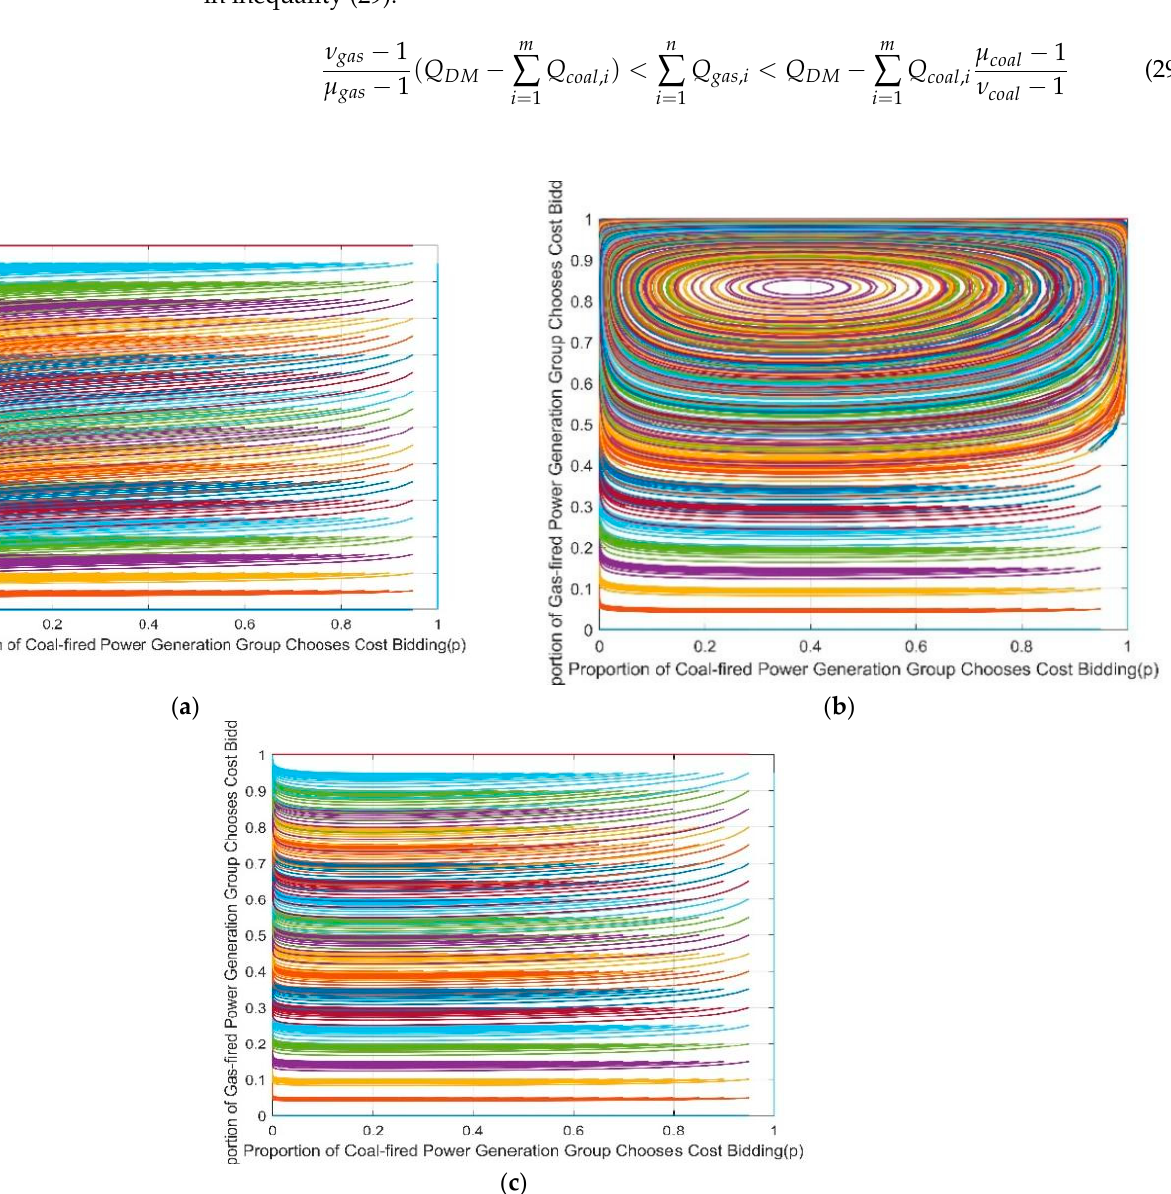
Figure 6. Evolution trend of bidding entities in phase 2 under scenario 1. ( a ) Simulation results of the evolution of coal-fired and gas-fired feed-in tariffs under "Condition 1" in Scenario 1.1-b, ( b ) Evolutionary simulation results under "Condition 2" in Scenario 1.1-b, ( c ) Simulation results for the evolution of "condition three" in scenario 1.1-b .